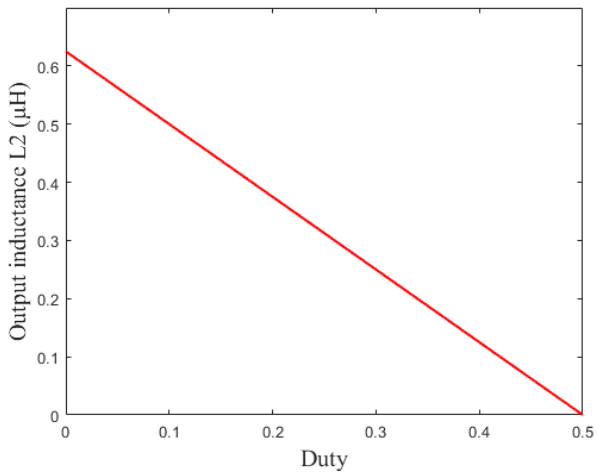
Figure 23. The calculated value of inductance L 2 in the boundary mode.